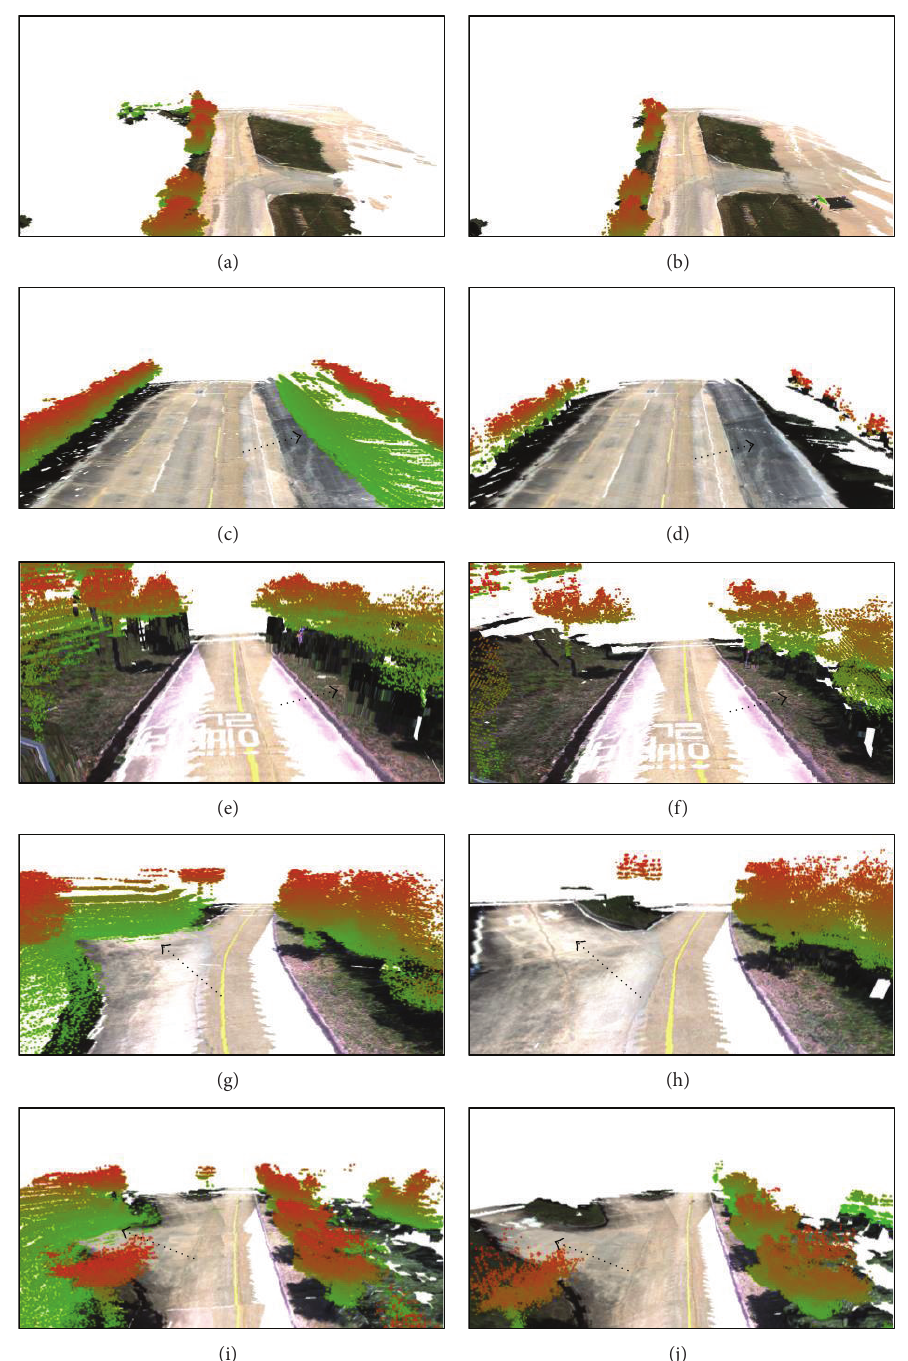
Figure 8: Ground segmentation results (the different parts are indicated by arrows). (a) Threshold based method result at a flat road. (b) Proposed method result at a flat road. (c) Threshold based method result at flat road with a slope. (d) Proposed method result at flat road with a slope. (e) Threshold based method result at a downhill road. (f) Proposed method result at a downhill road. (g) Threshold based method result at an uphill road. (h) Proposed method result at an uphill road. (i) Threshold based method result at another uphill road. (j) Proposed method result at another uphill